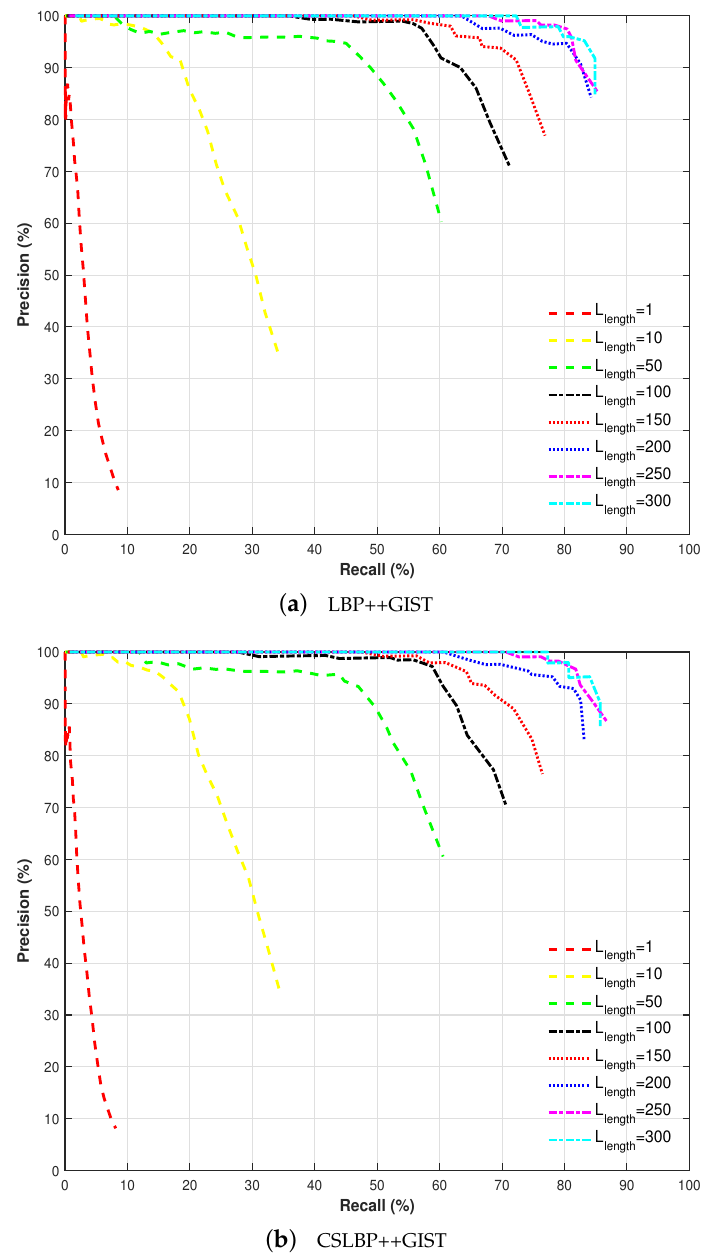
Figure 6. Performance comparison of our proposed method with different feature combination, according to image sequence length L length (spring vs.